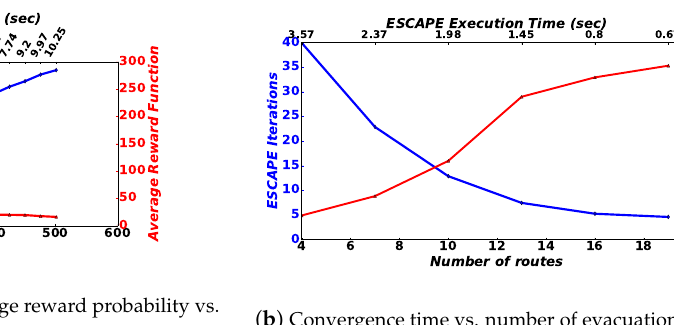
( b ) Convergence time vs. number of evacuation routes Figure 4. Scalability